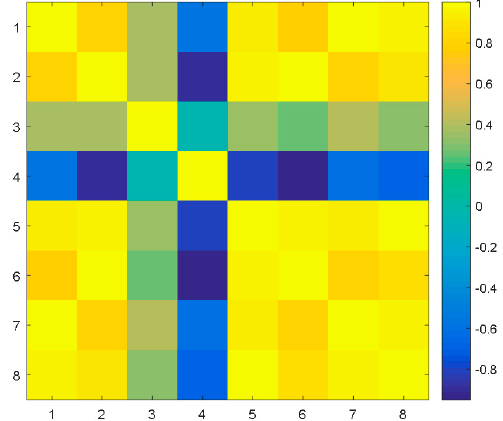
Figure 2. Correlation plot between the energy demand and selected factors.